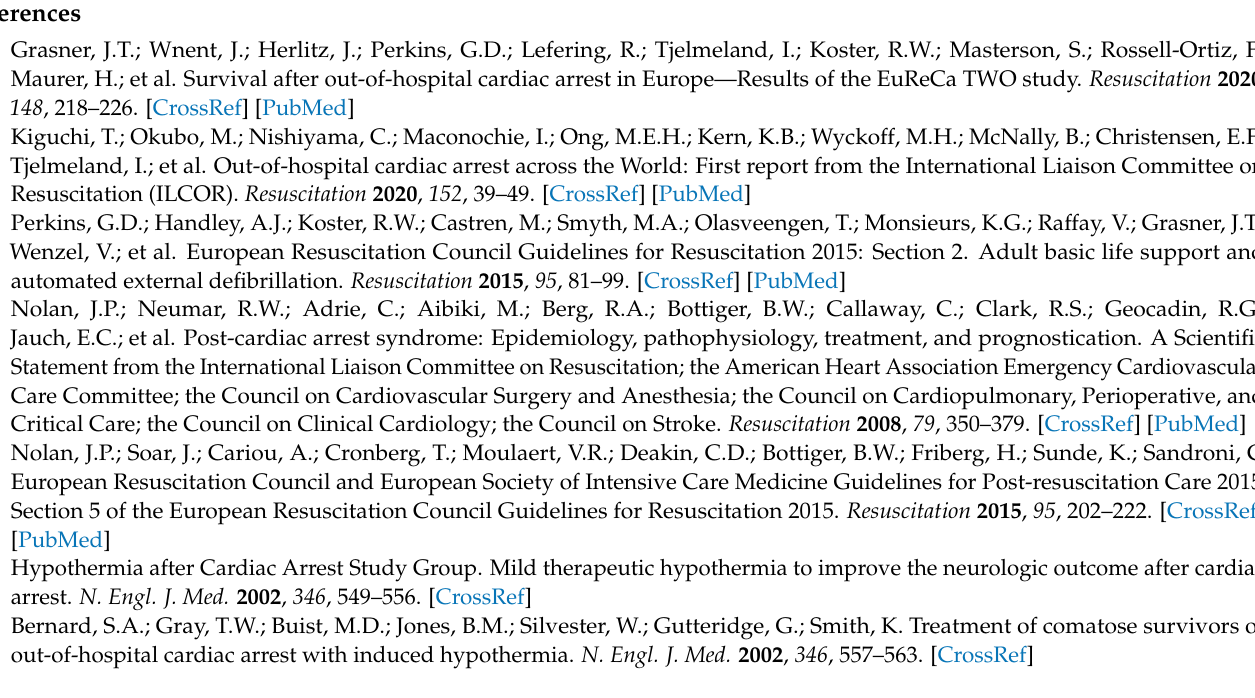
Figure S6. Changes of dopamine dosage during target temperature management in PiCCO™ and non- PiCCO™ groups. Figure S7. Changes of dobutamine dosage during target temperature management in PiCCO™ and non-PiCCO™ groups. Figure S8. Changes of noradrenaline dosage level during target temperature management in PiCCO™ and non-PiCCO™ groups. Table S1. Characteristics of patients and initial therapy regarding PiCCO™ use, 30 day and 1 year